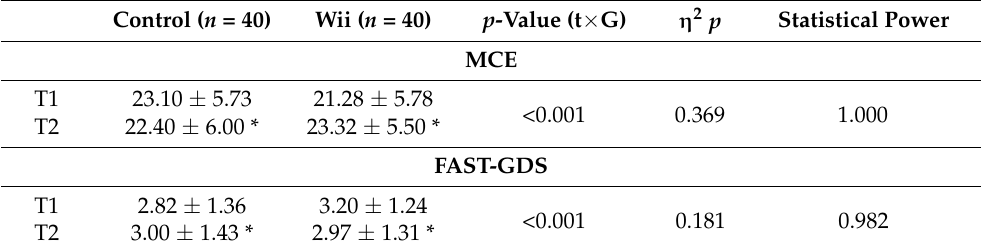
Table 3. Cognitive data of the control group and Wii group before and after the intervention.